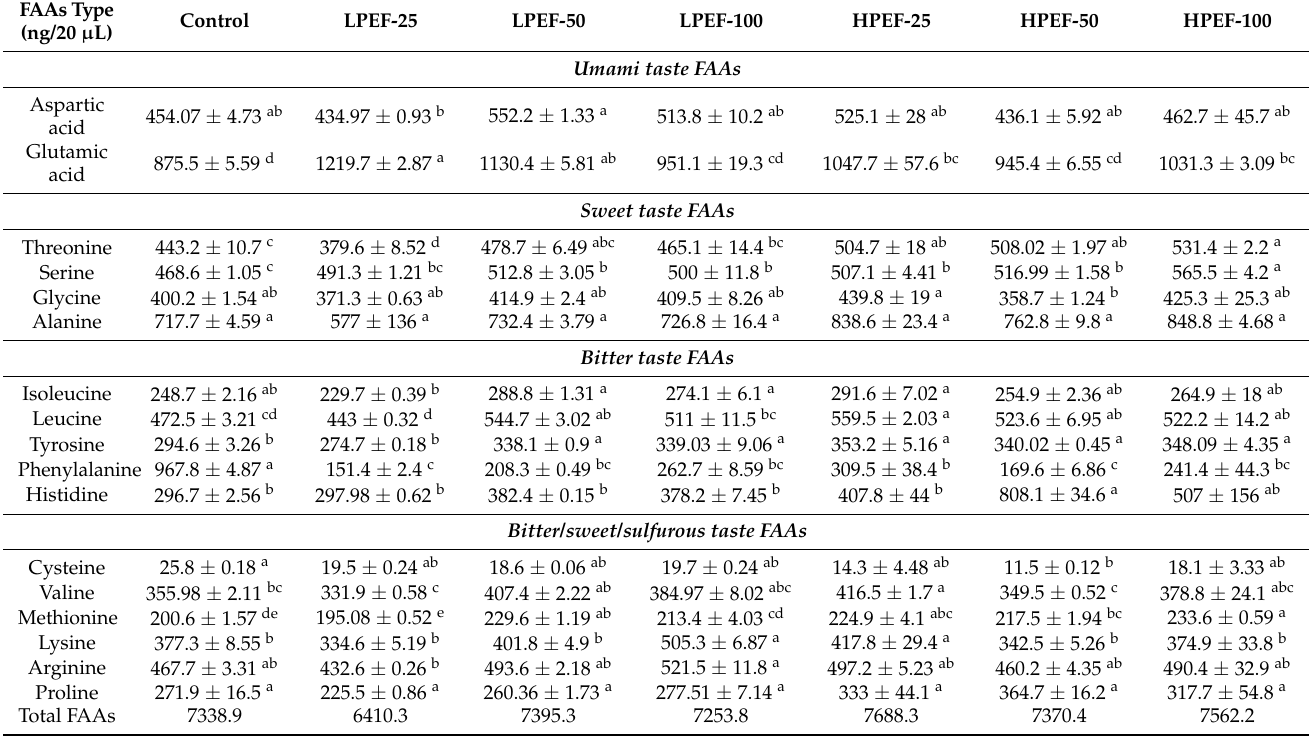
Table 3. Free amino acid contents of chicken breast influenced by different pulsed electric field